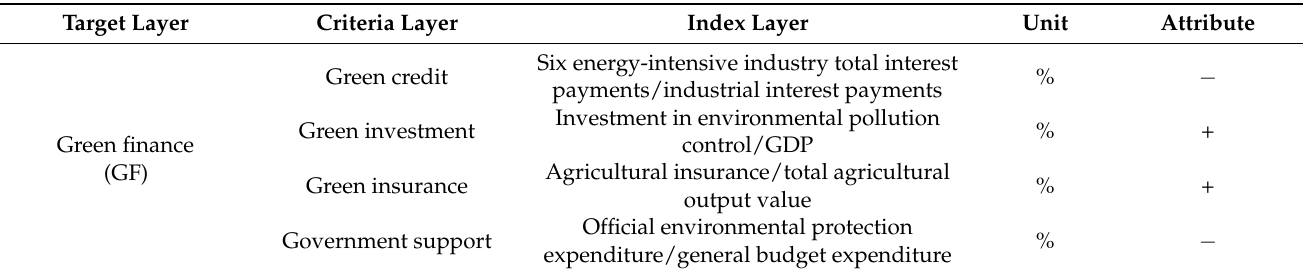
Table 2. Indicator system of green